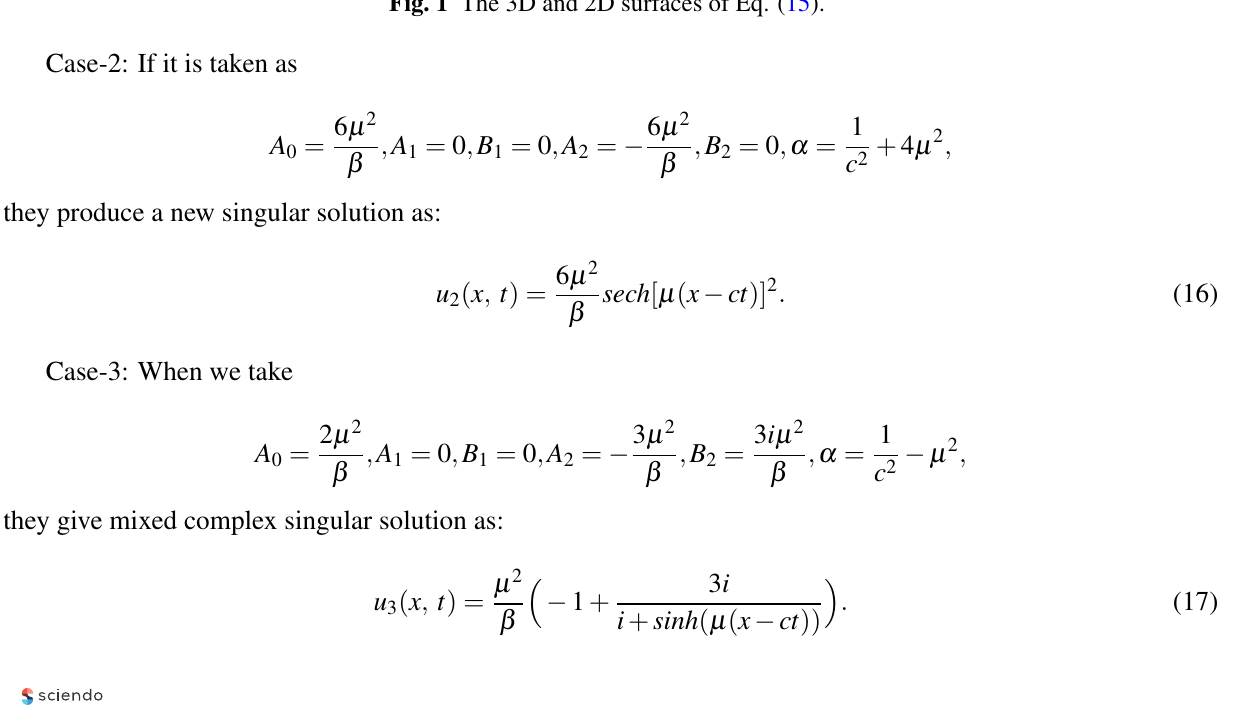
Fig. 1 The 3D and 2D surfaces of Eq.